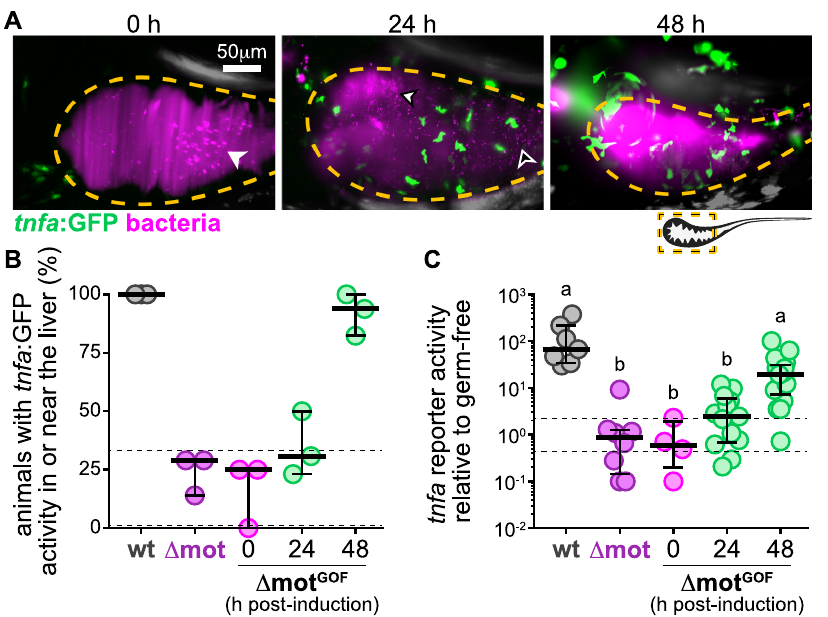
Fig 7. Host tissues rapidly respond to sudden increases in bacterial swimming motility within the intestine. (A) Maximum intensity projections acquired by LSFM of the foregut region of separate tnfa :GFP transgenic zebrafish colonized with Δ mot GOF (magenta). Dashed lines mark approximate intestinal boundaries. Times are hours post switch induction. Solid arrowhead marks bacterial aggregates, empty arrowhead marks single bacterial cells. (B) Percent of zebrafish subjected to different colonization regimes with tnfa :GFP activity in or near the liver; > 4 animals/ group were blindly scored by 3 researchers. Bars denote medians and interquartile ranges. Data from animals colonized with wt Vibrio or Δ mot (from Fig 6B) are shown for comparison. Horizontal dashed lines mark gf range plotted in Fig 6B. (C) Total GFP fluorescence intensity across the foregut region normalized to median gf fluorescence intensity plotted in Fig 6C; horizontal dashed lines mark gf range. Bars denote medians and interquartile ranges. Data from animals colonized with wt Vibrio or Δ mot (from Fig 6C) are shown for comparison. Letters denote significant differences. p < 0.05, Kruskal-Wallis and Dunn’s multiple comparisons test. Underlying data plotted in panels B and C are provided in S1 Data. gf, germ-free; GFP, green fluorescent protein; LSFM, light sheet fluorescence microscopy; wt, wild